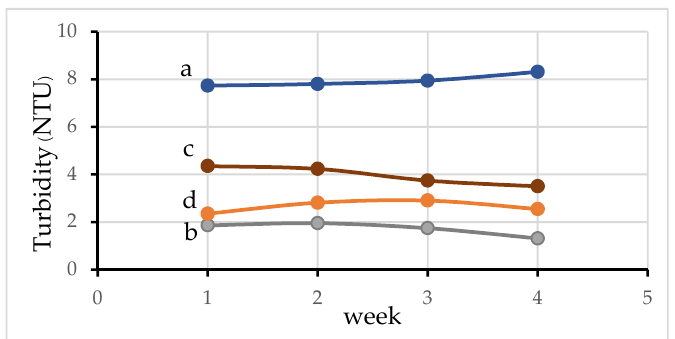
Figure 9. Turbidity values of the water in ( a ) pond 1; ( b ) the hydroponic system without aquaculture pond; ( c ) pond 2; ( d ) and pond 3.